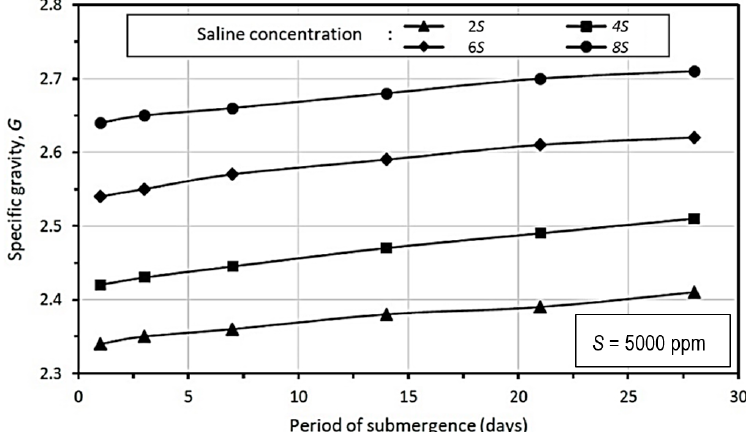
Figure 3. Variation of G with period of submergence.